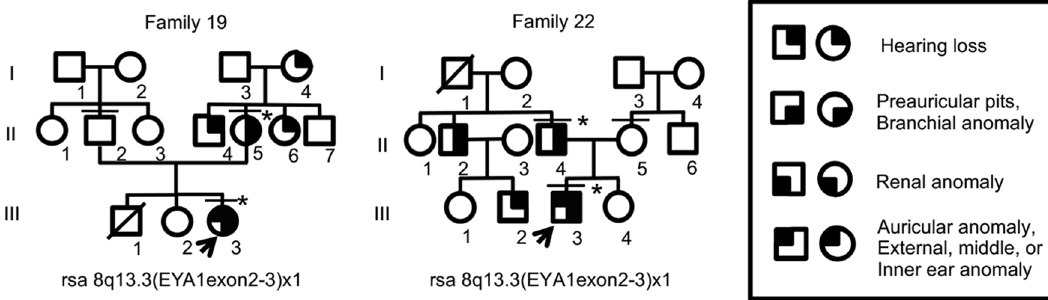
Figure 2. The pedigree of families with atypical BOR syndrome and with P/LP variants. For the meaning of the symbols, see the legend of Fig. 1.